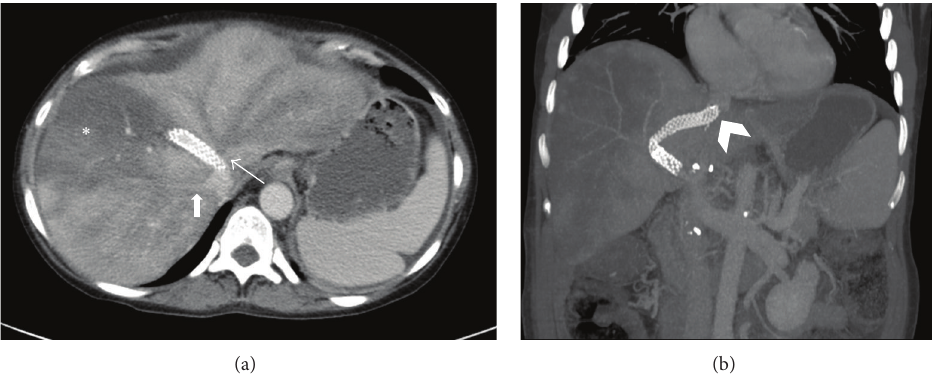
Figure 3: (a) Axial contrast-enhanced CT of the upper abdomen during the portal-venous phase demonstrates thrombosed left and middle hepatic veins ( thin arrows ). The proximal end of the TIPS stent is seen within the IVC which is occluding ostia of the left and middle hepatic veins ( black arrow ). The right hepatic vein is patent and adequately opacified with IV contrast ( thick arrow ). A wedge-shaped hypodense area in hepatic segments V and VIII ( asterisk ) representing hepatic infarction. (b) Coronal MIP image of the upper abdomen shows the position of the TIPS stent, communicating the right portal vein and the mid hepatic vein with its most cranial tip within the IVC ( arrowhead ).